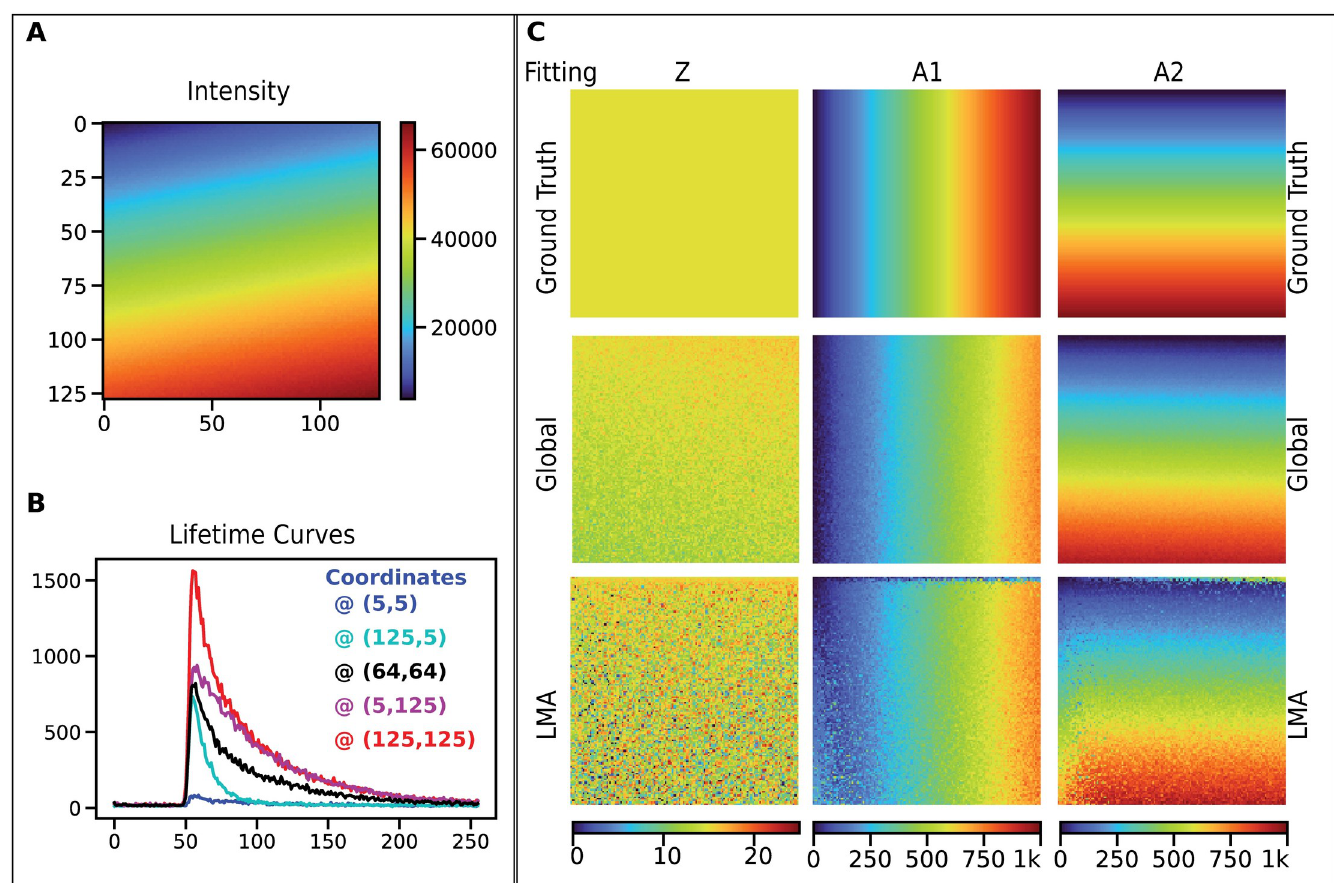
Fig 6. FLIM Validation using simulated 2-component lifetime data. The figure shows the simulated data with fixed lifetime values, 2.1 ns, and 0.4 ns. A) The intensity image for the simulated dataset is shown here. Note that this scale is for photons. B) Five sample lifetime curves are shown to demonstrate the variation in their intensity levels and decay rates. C) This panel compares the Global fitting routine and LMA for the two-component model. The color maps are the same between the panels of each parameter. The three parameters shown are Z (offset), A1 (amplitude of species 1), and A2 (amplitude of species 2). Both LMA and Global fitting reproduce the apparent fraction of two species, but we find that global fitting yields less noise and works twice as fast. (This dataset is provided in the SCIFIO sample datasets or https://samples.scif.io/Gray-FLIM-datasets.zip).